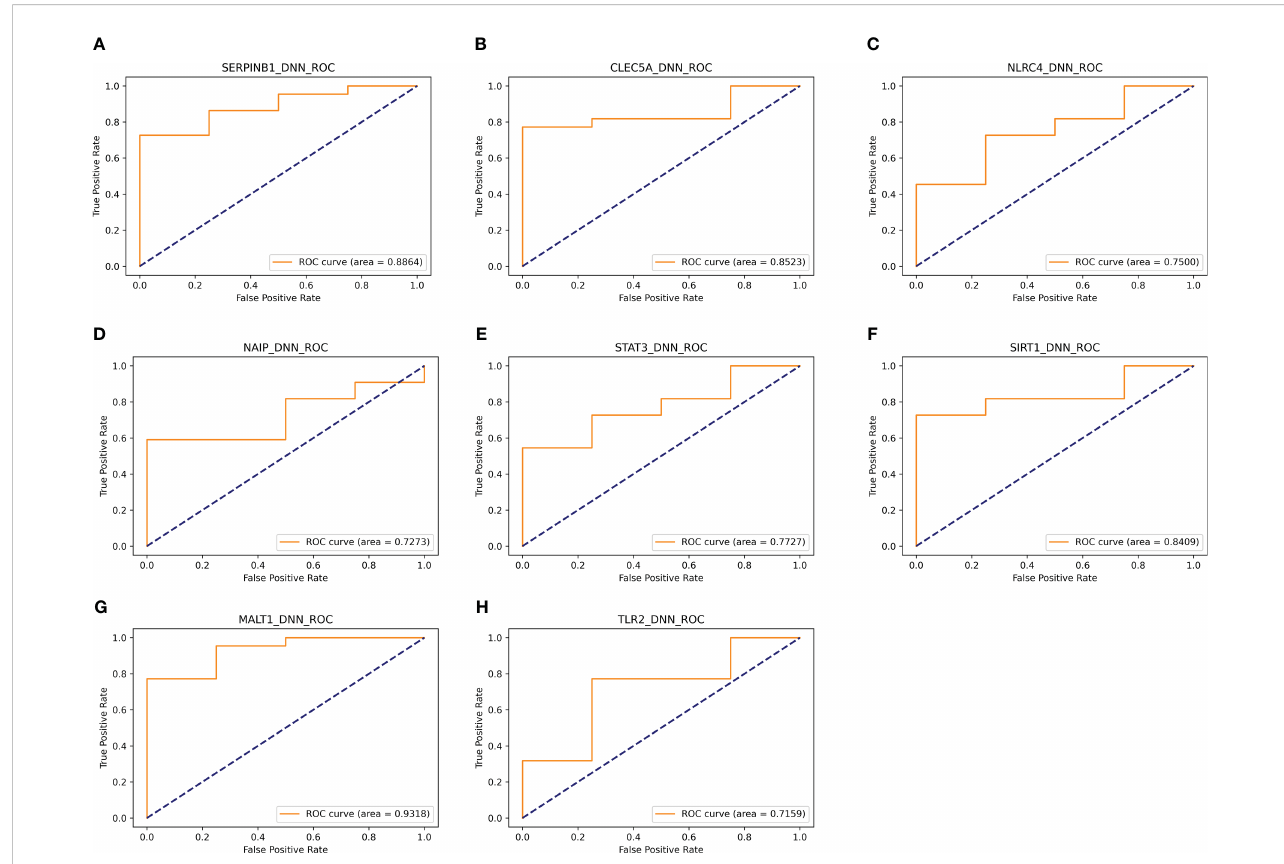
FIGURE 4 Results of separate validation of the top eight genes on the internal validation set. (A – H) are ROC curves for the top 8 genes,